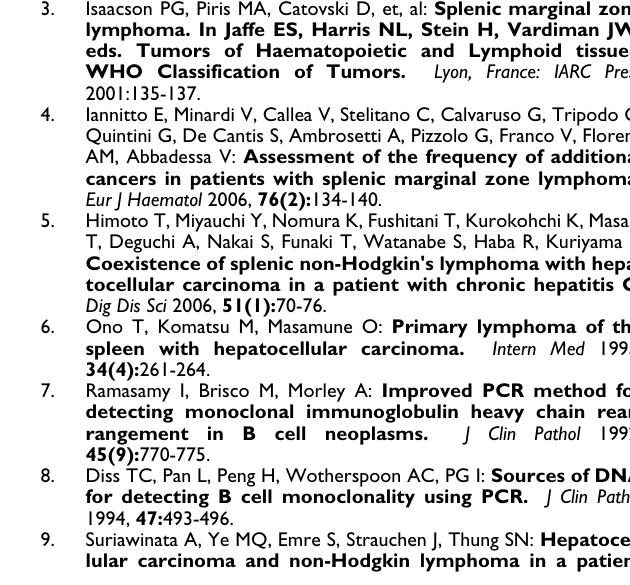
cell lesion lymphoma used as positive control. Lane 2, FR2, chronic tonsillitis used as negative control. Lane 3, FR2, sample col- lected from splenic marginal zone lymphoma showing monoclonal pattern. Lane 4, Joining region (JH), sample collected from splenic marginal zone lymphoma showing a smear. Lane 5, JH, anaplastic large cell lymphoma used as positive control. Lane 6, JH, chronic tonsillitis used as negative